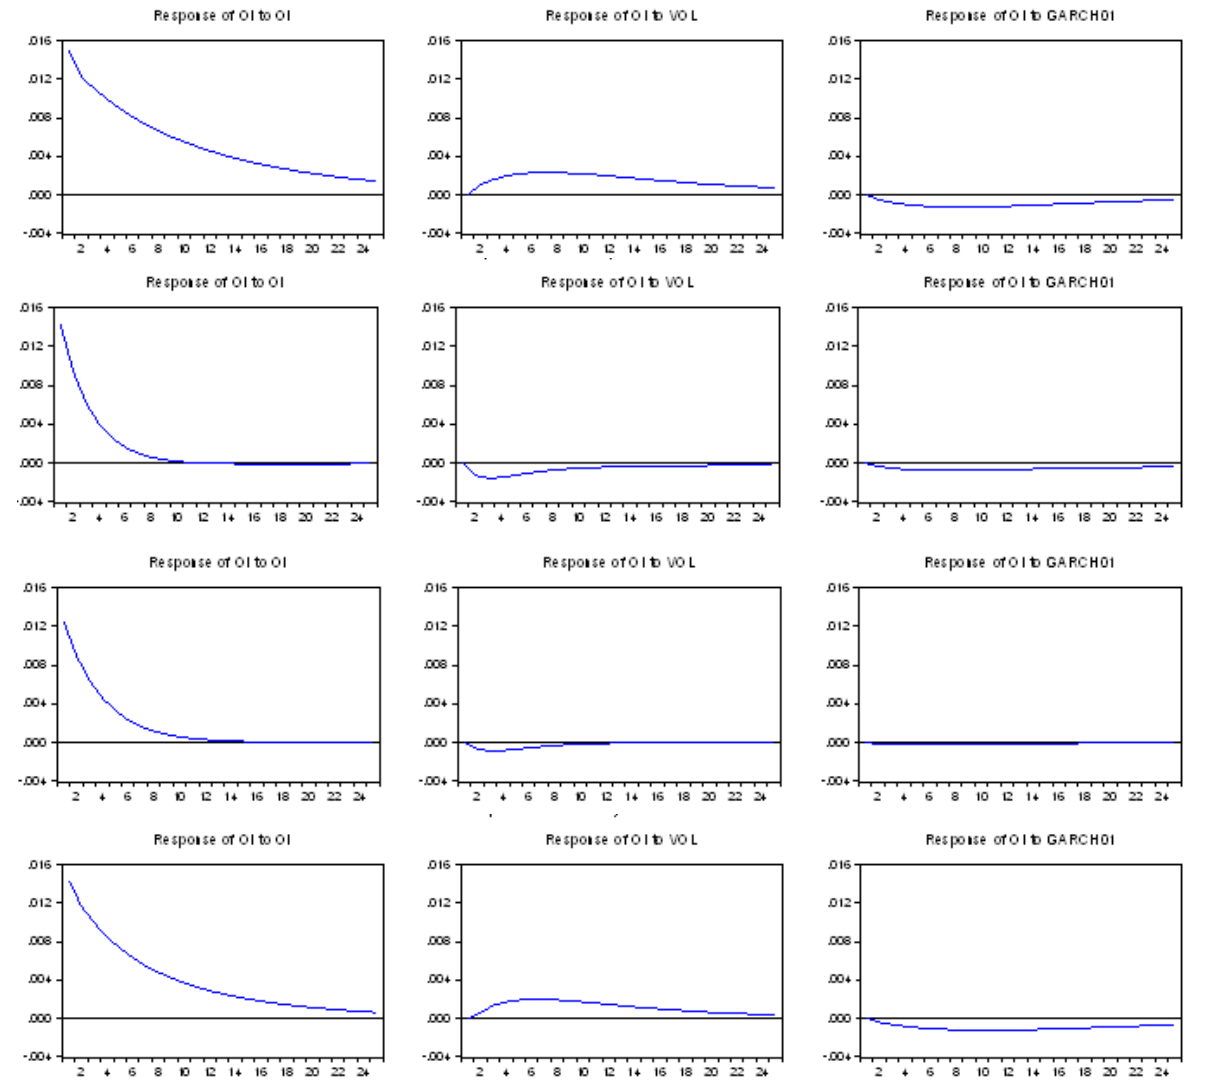
Fig. 2. Impulse response of open interest to shocks in volume and volatility over three sub-periods for contract size starting with 200 (first row), followed by 100 (second row), 50 (third row) and, finally, for the full period (fourth row).First, second and third column starting from left reflect impulse response of open interest toshocks of its own, volume and volatility,